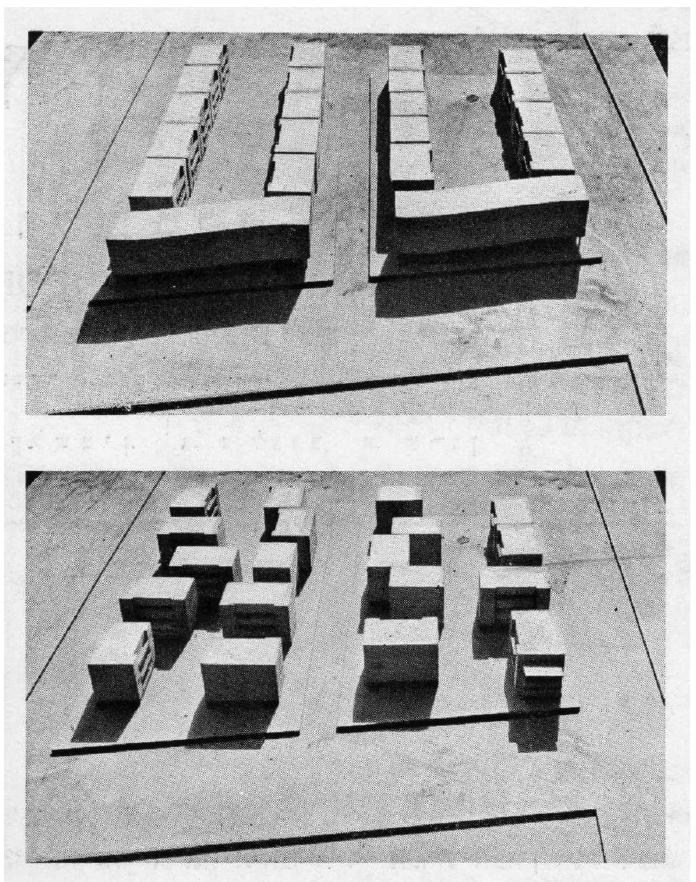
Figure 12. Arie Sharon’s proposal for Me’Onot Ovdim (worker residence) in response to Tel Aviv home-block densification, 1937. Source: Sharon